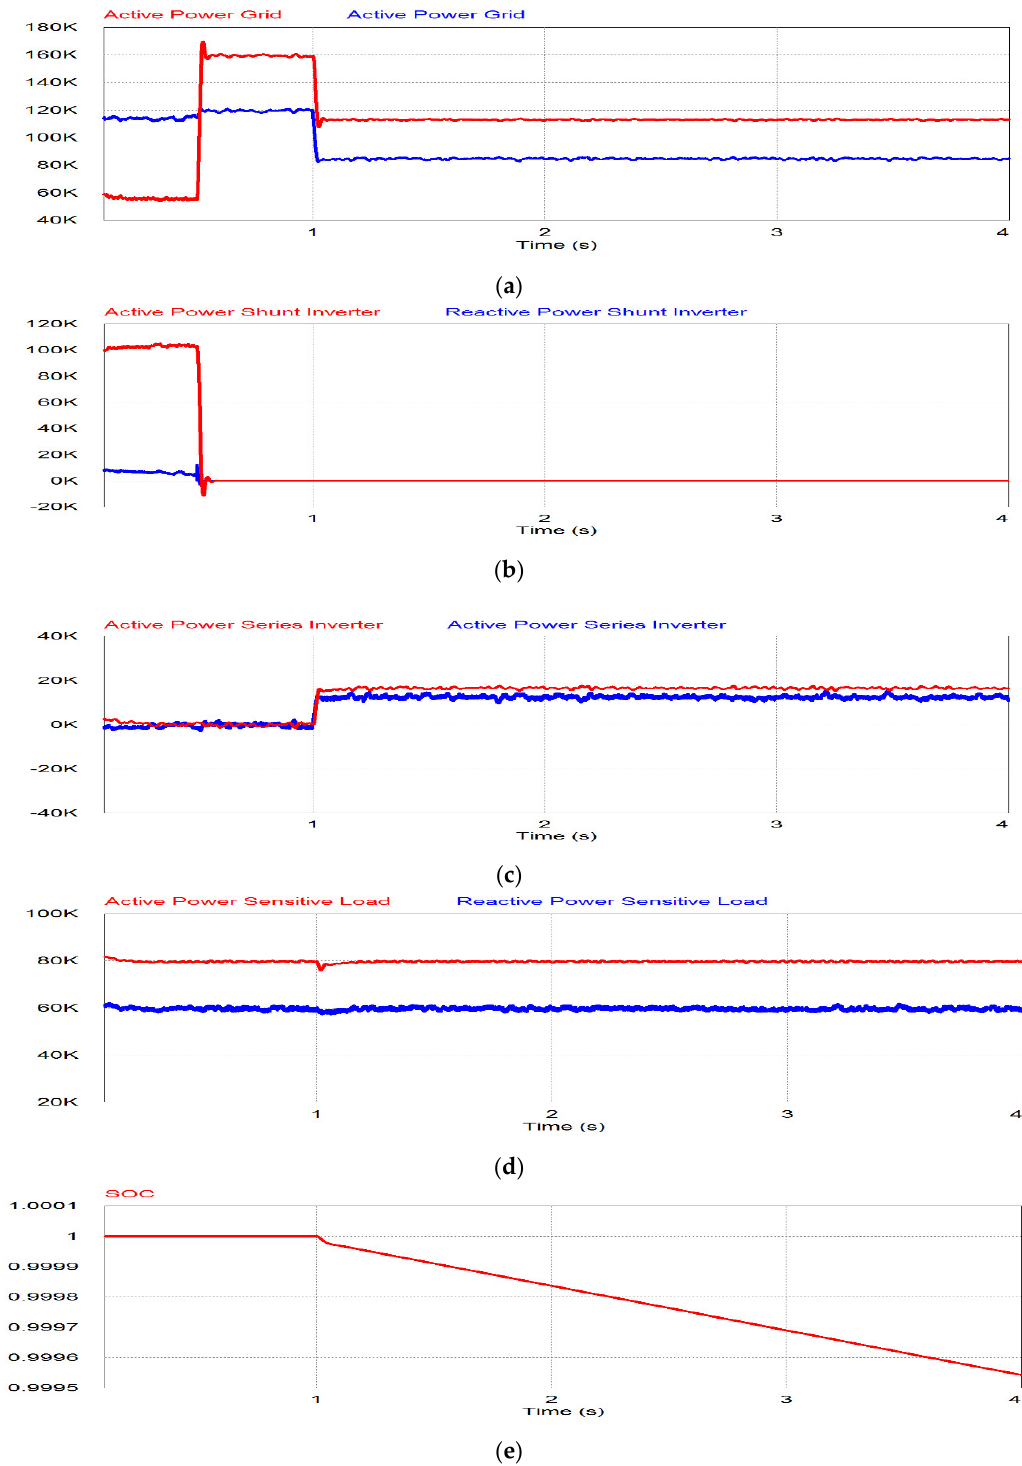
Figure 17. Simulation results of BESS: ( a ) Grid power; ( b ) shunt inverter power; ( c ) series inverter power; ( d ) active and reactive power for sensitive load; ( e ) SoC of BESS.